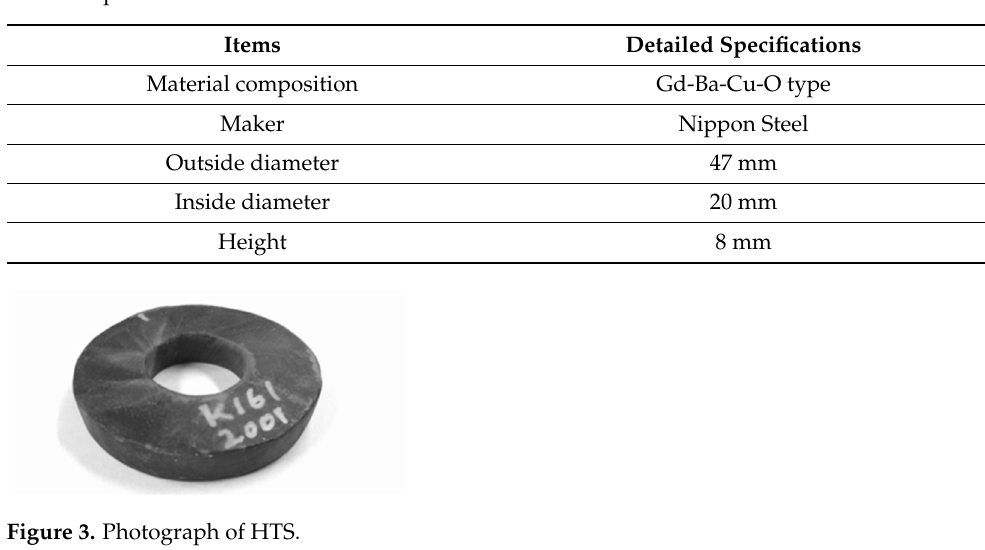
Figure 2. HTS magnet configuration with repulsive permanent magnet. Table 1. Specifications of the HTS.